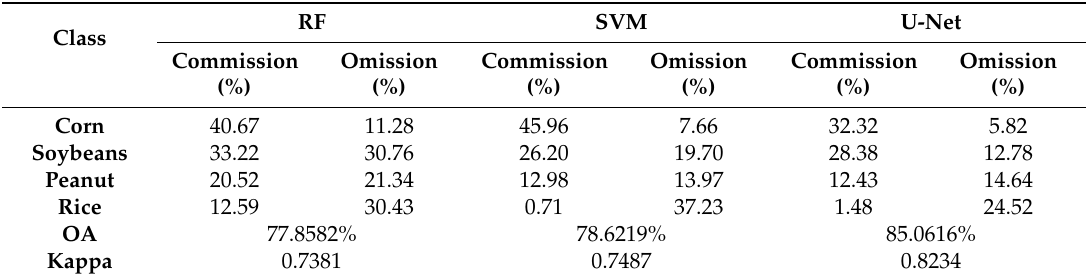
Table 7. Accuracy assessment of crop classification results based on confusion matrix.